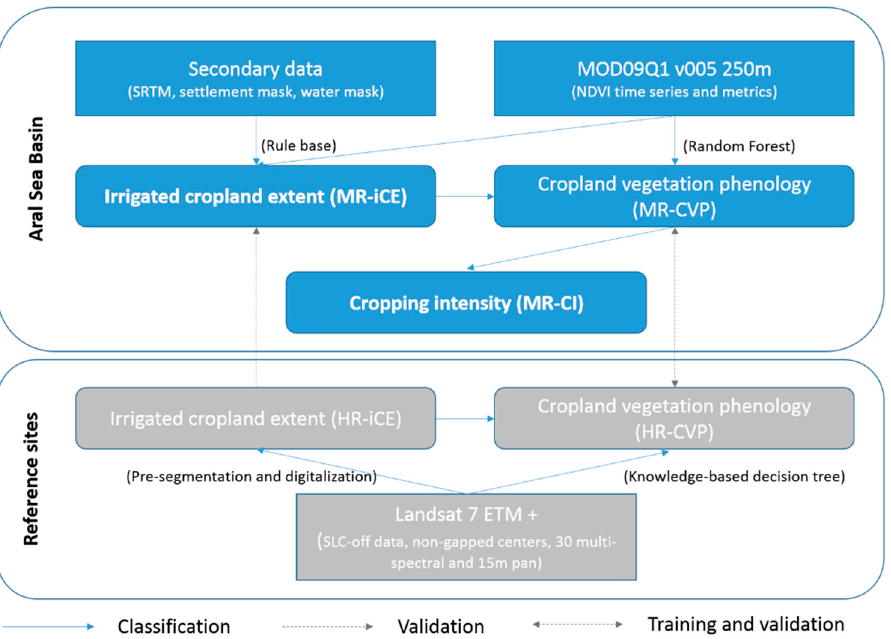
Figure 2. Overview on the data sets and approaches for mapping the irrigated cropland extent (iCE), cropland vegetation phenology (CVP), and the cropping intensity (CI). The according procedures are indicated in brackets. Local scale analysis served as reference for the regional maps for the ASB. Note, MR = moderate-resolution, HR = high-resolution.